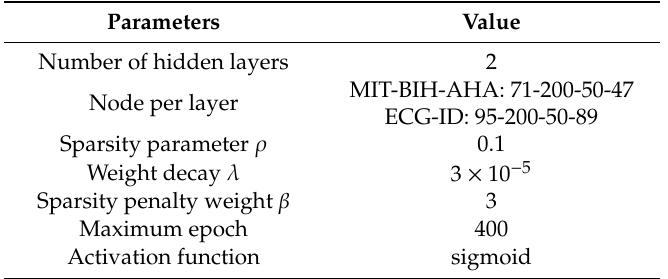
Table 2. Parameter setting of the proposed